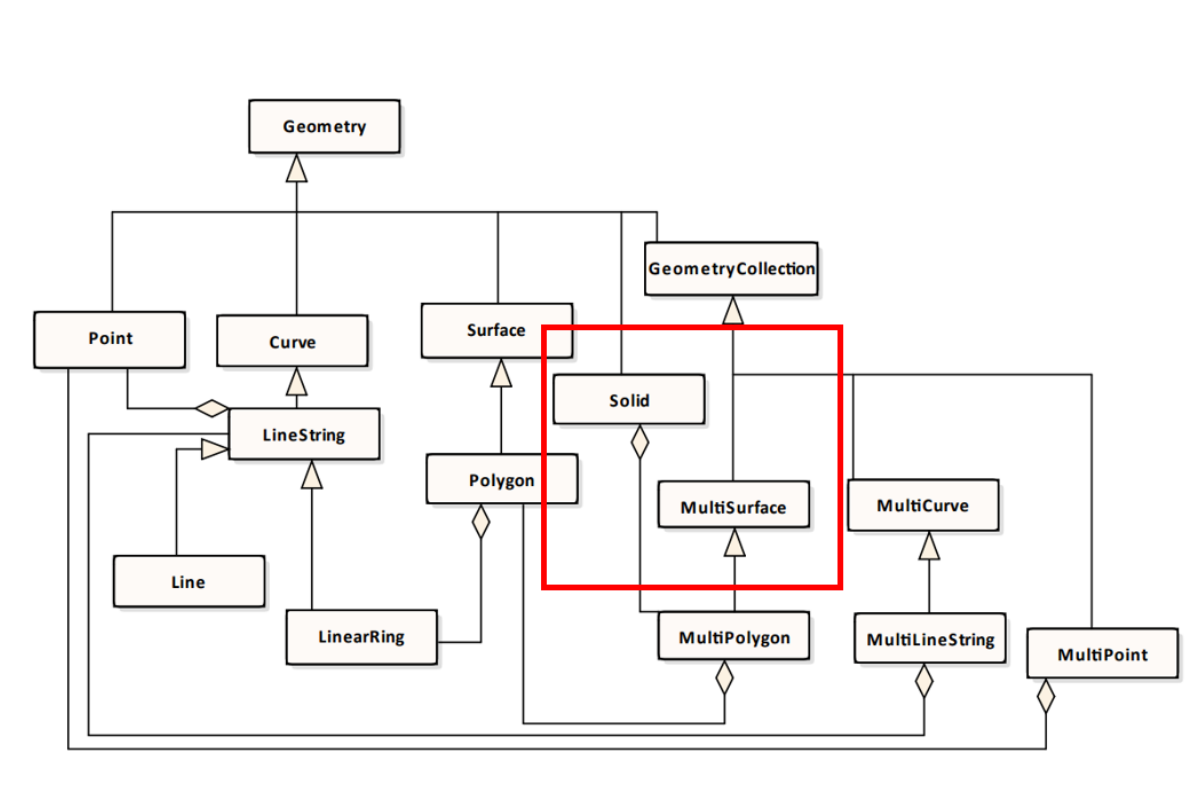
Figure 7. The extended model of Simple Feature Geometry